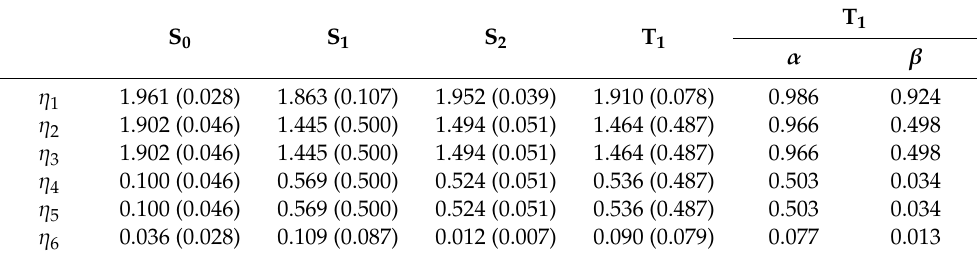
Table 1. Active-space NO occupation numbers for the S 0 , S 1 , S 2 and T 1 states of C 6 H 6 and active-space NSO occupation numbers for the T 1 state (all in descending order). Values in brackets show the net contributions from all determinants in which a particular NO is singly occupied.